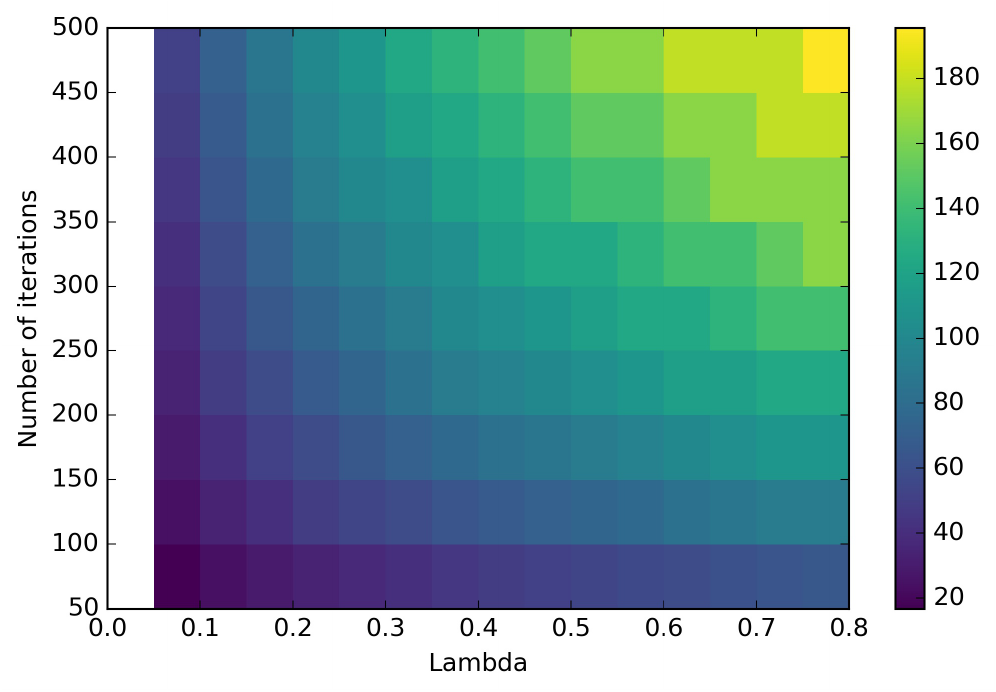
Figure A2. Laplacian diffusion cut-off wavelengths (km) for different combinations of the number of iterations and